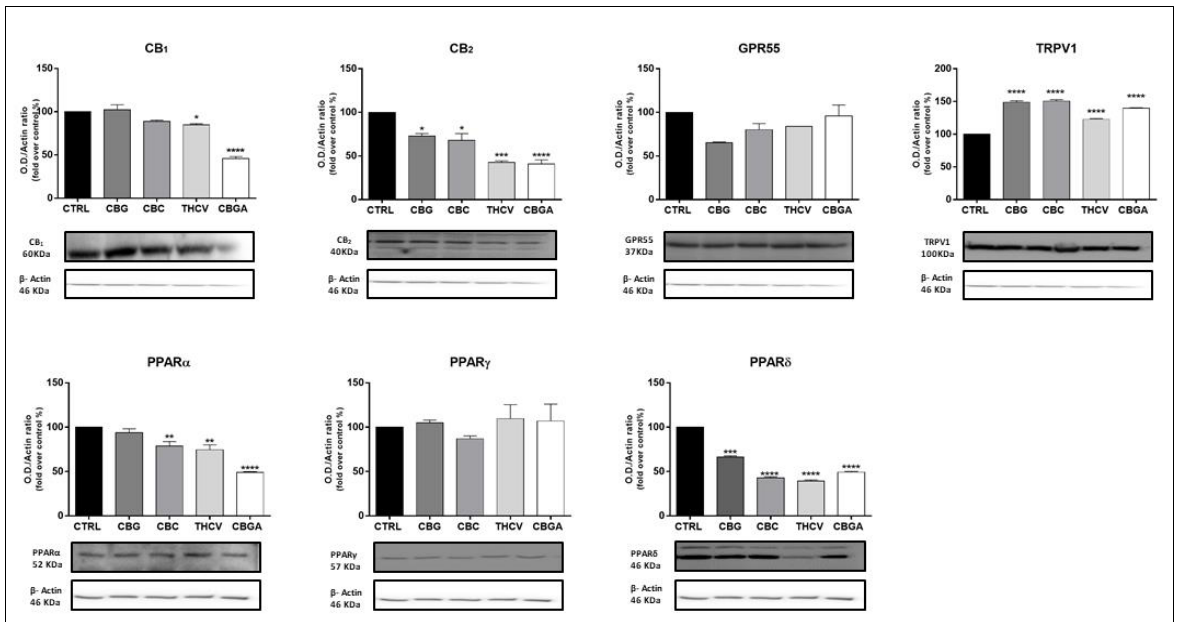
Figure 4. Protein expression of eCB-binding receptors (CB 1 , CB 2 , GPR55, TRPV1 and PPARα/γ/δ) following 24 h of treatment with half-IC 50 amounts of: CBG, CBC, THCV and CBGA. Densitometric analyses of eCB- binding receptors immunoreactive bands were normalized to β -actin as the housekeeping protein and were presented as fold change over control (%). The data are the means ± SEM of three independent experiments ( n = 3). Statistical analysis was performed using a one-way ANOVA test, followed by the Bonferroni post hoc test (* p < 0.05, ** p < 0.01, *** p < 0.001 and **** p < 0.0001 vs. control).